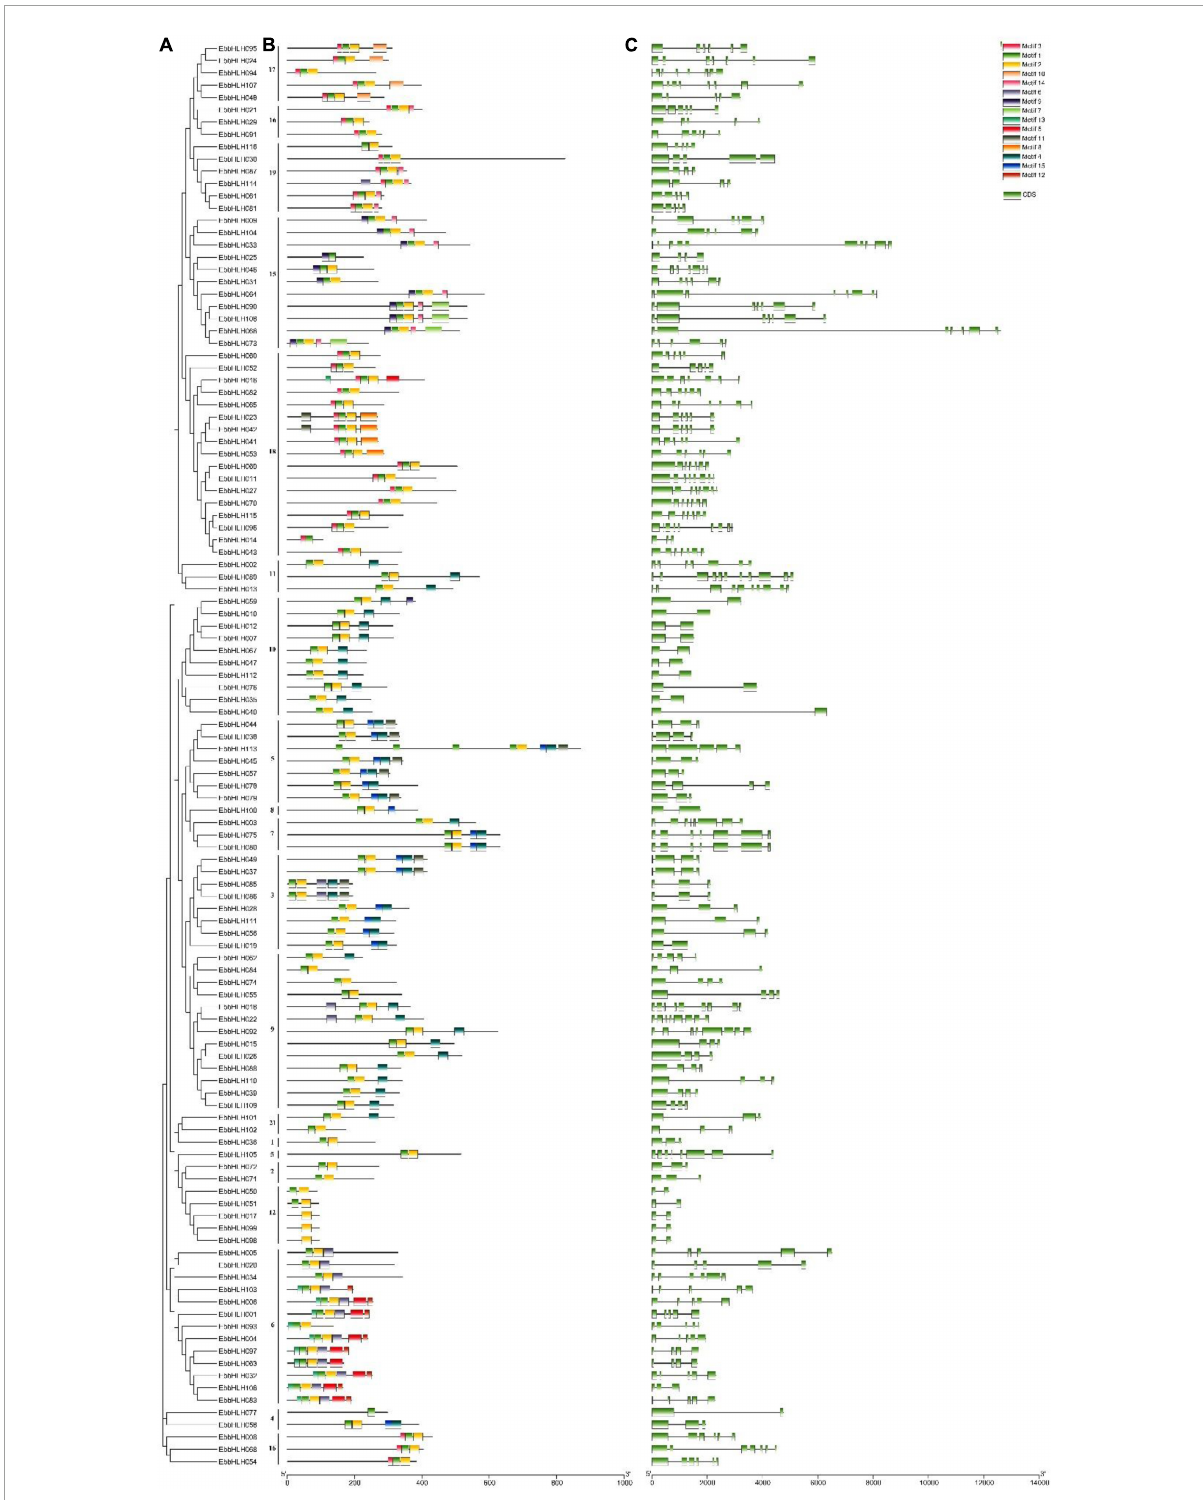
FIGURE2 Phylogenetic analysis, gene structure and motif distribution analysis of the bHLH gene family of E. breviscapus . (A) Phylogenetic trees were constructed by the NJ method, repeated 1,000 times at each node. (B) Fifteen amino acid motif in the EbbHLH protein is indicated by a colored box. (C) Exons and introns are indicated by green rectangles and gray lines,